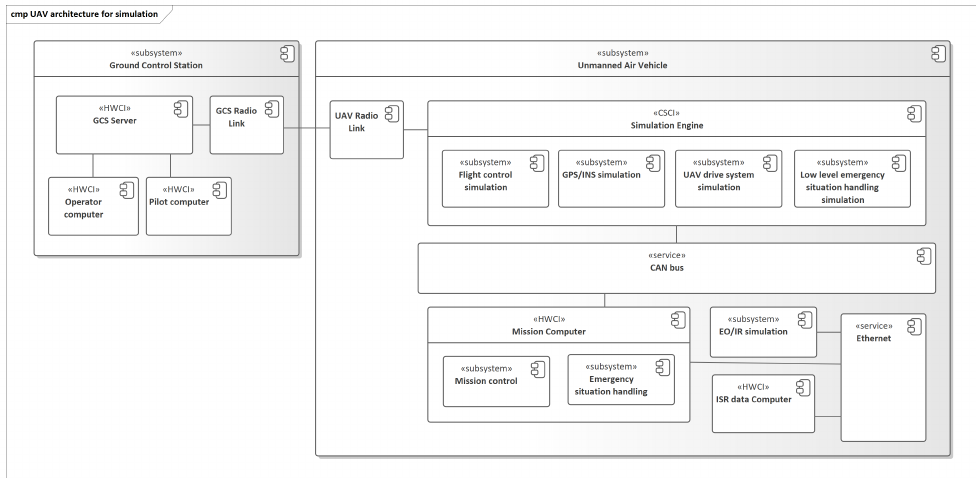
Figure 5. The physical architecture of UAV with additional simulation units. Simulation packages replace FCC. The remaining UAV components remained